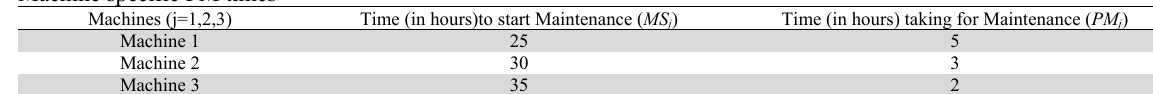
Machine specific PM times